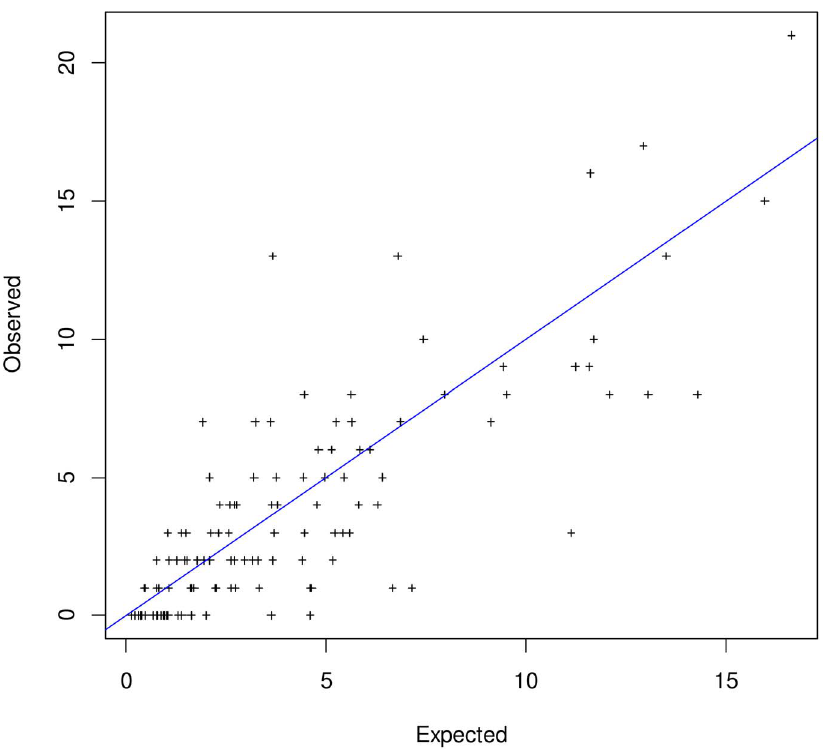
Figure 3. Observed versus expected occurrence for 2-type human papillomavirus infections, 9,949 samples from men, Sweden. Plus signs represent occurrences of HPV pairs. HPV pairs located in the upper triangle indicate positive clustering, while those located in the lower triangle represent negative clustering between the HPV types involved. There were no significant p-values for joint HPV infections at the chosen significance level of 0.0004.